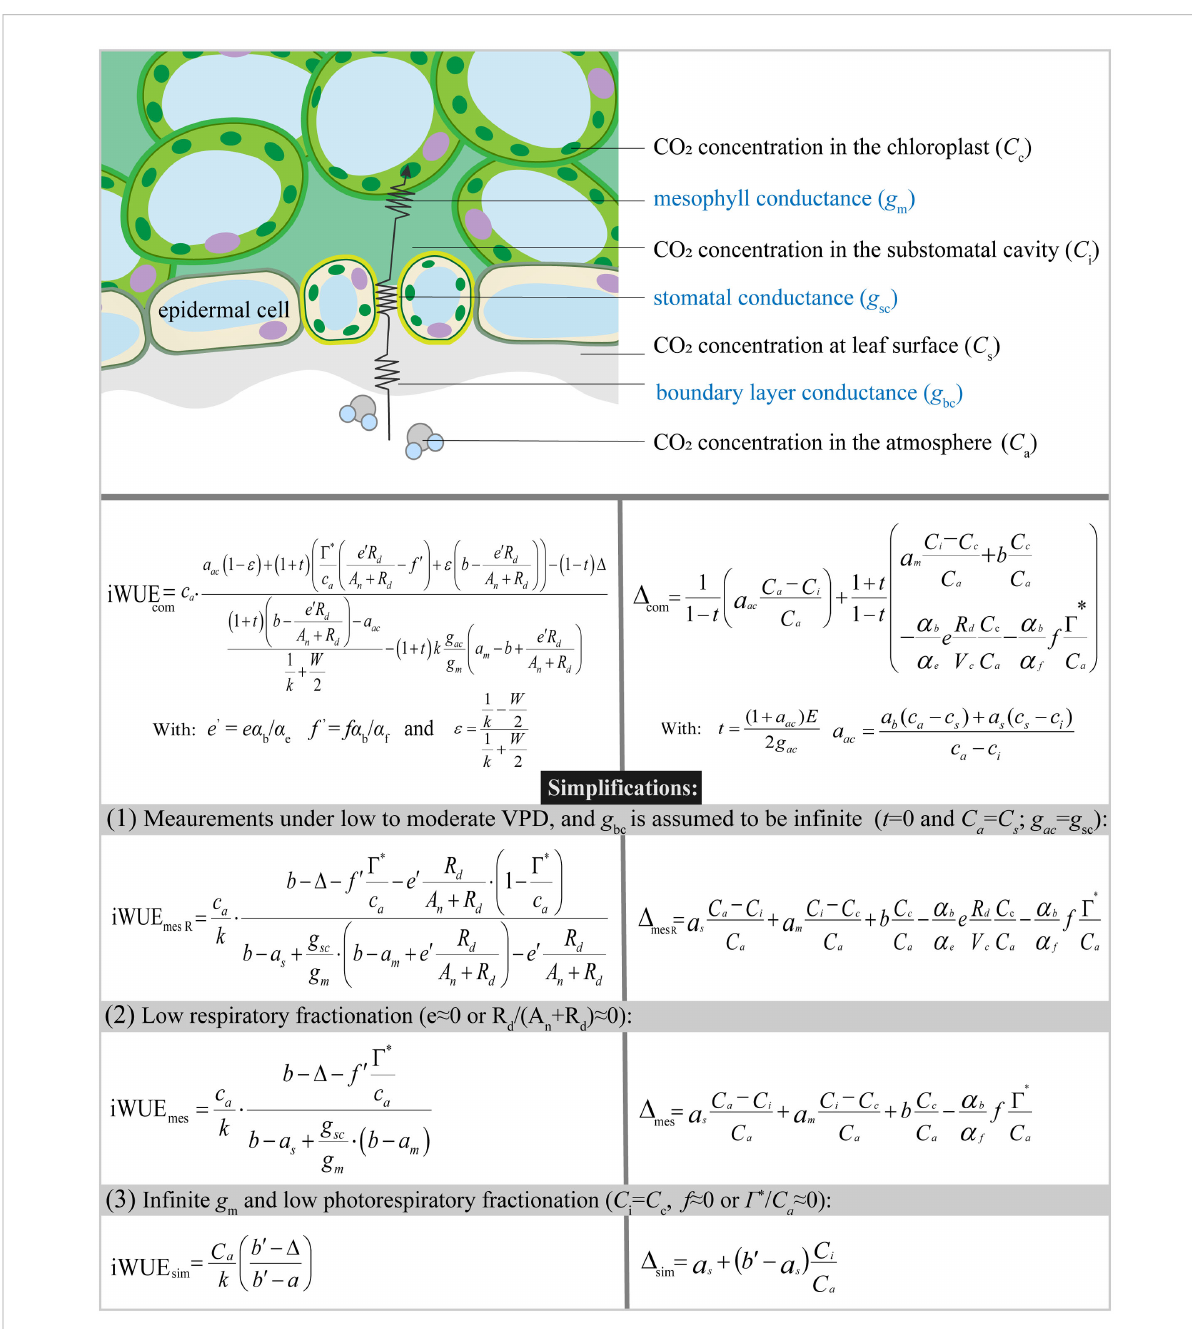
FIGURE 1 Diagram of the CO 2 diffusion pathway in C 3 leaves and different formulations of iWUE (iWUE com , iWUE mes R , iWUE mes , and iWUE sim ) derived from the Farquhar et al. model for photosynthetic 13 C